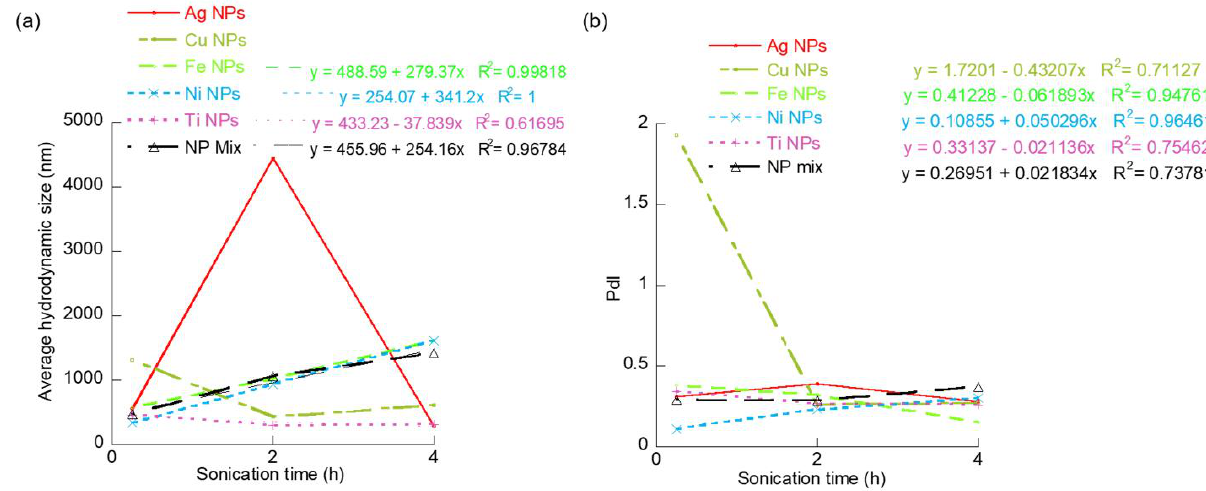
Figure 4. Effect of suspension time on dispersion quality of various MNPs in terms of ( a ) average hydrodynamic size and ( b ) PdI.